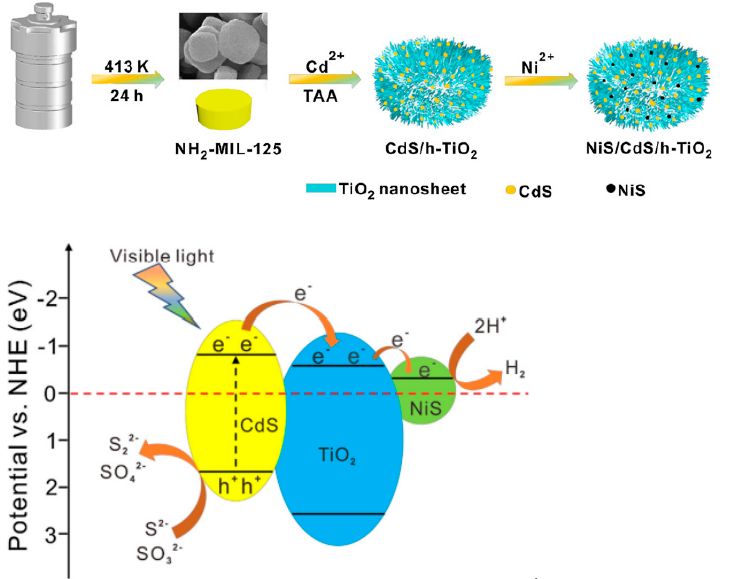
Figure 12. Schematic illustration of the synthetic procedure of NiS/CdS/h-nanocomposites with schematic of the photocatalytic mechanism of H 2 production on NiS/CdS/h-TiO 2 photocatalysts [121]. Table 4. Hierarchical catalysts produced by using hybrid templates.